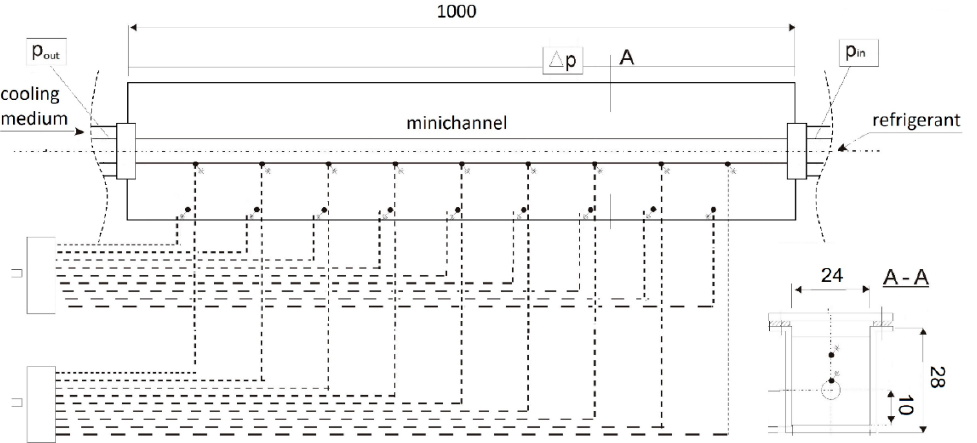
Figure 2. Framework of the measuring section.